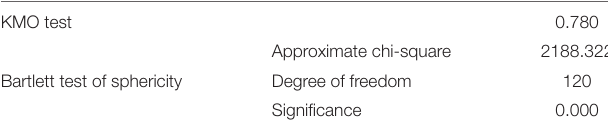
TABLE 5 | KMO test and Bartlett test of sphericity of the PsyCap